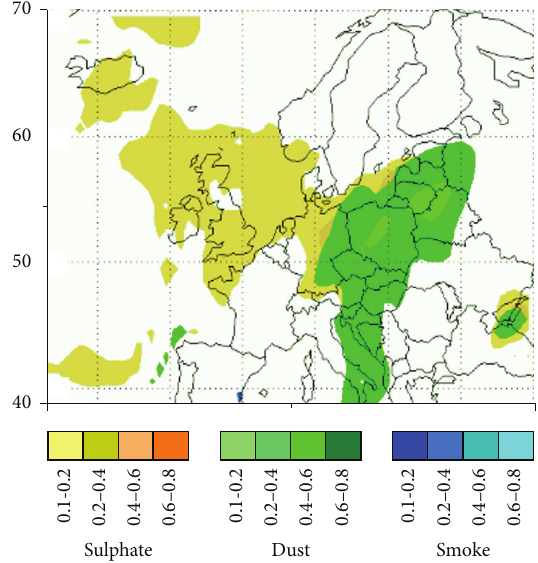
Figure 8: The dust distribution over Europe on the 3rd of July by satellite measurements and NAAPS distribution